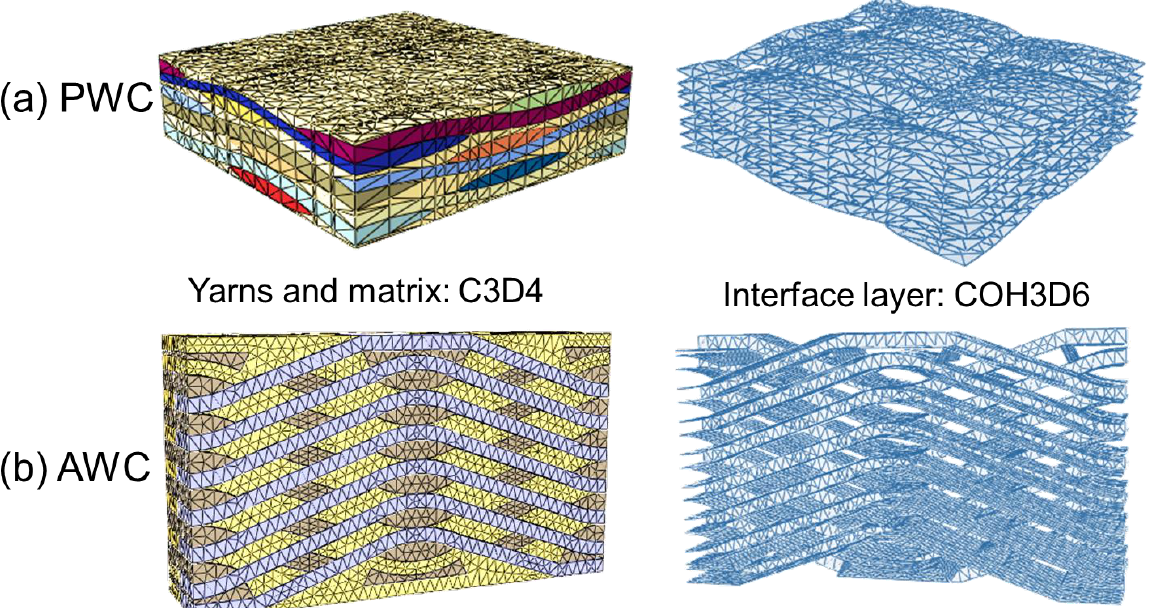
Figure 3. Finite element models: ( a ) 2-D PWC; ( b ) 2.5-D AWC.